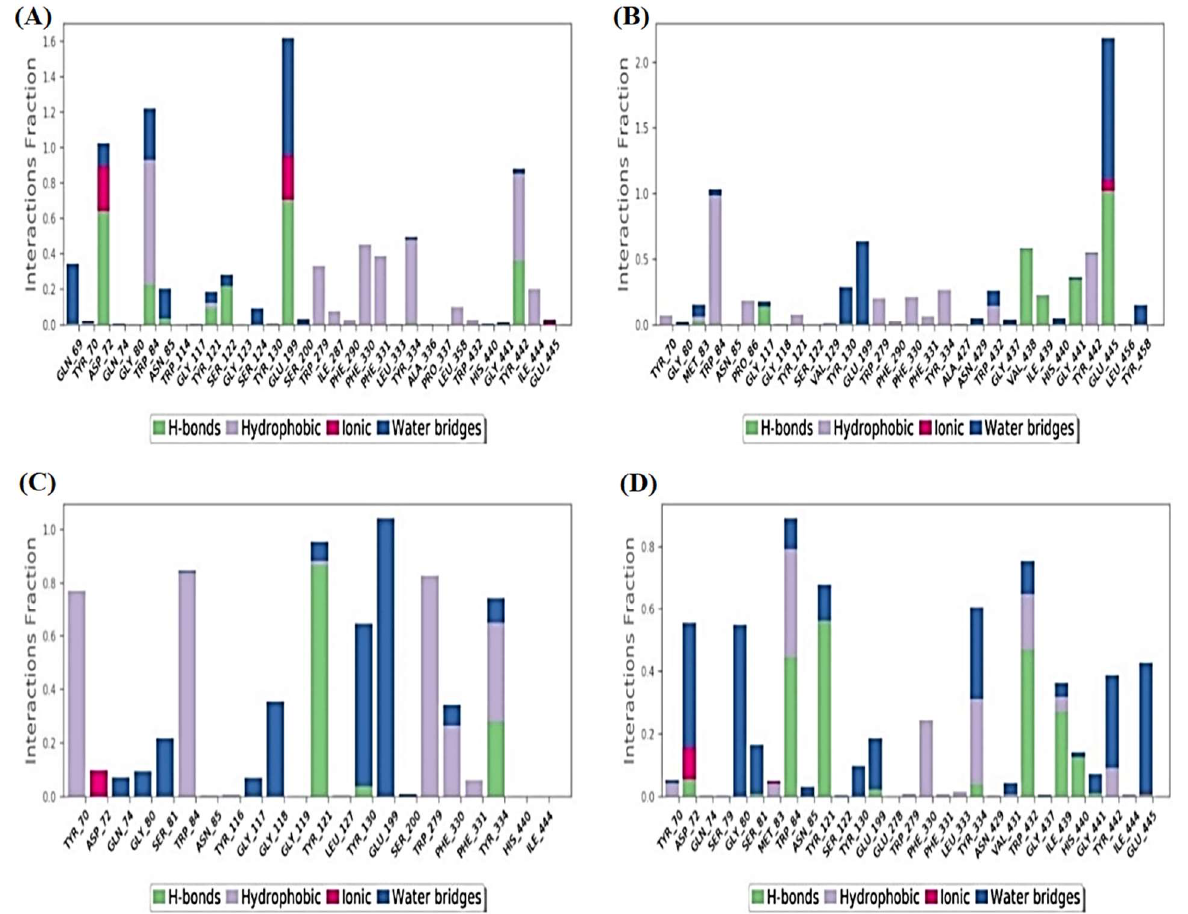
Figure 7. Histograms describing the binding interactions fraction between the protein and its ligand for: ( A ) normethyl budmunchiamine K-1OCE; ( B ) budmunchiamine L5-1OCE; ( C ) donepezil-1OCE and ( D ) MF2 700-1OCE complexes.